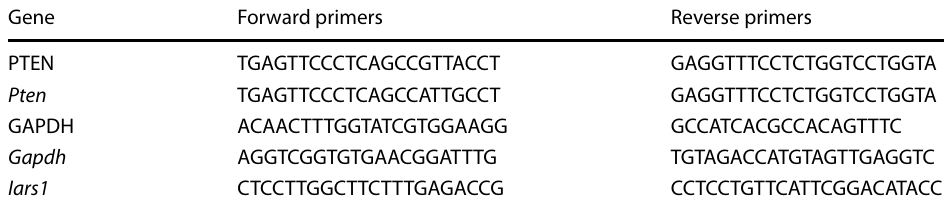
Table 1 The primer sequences information